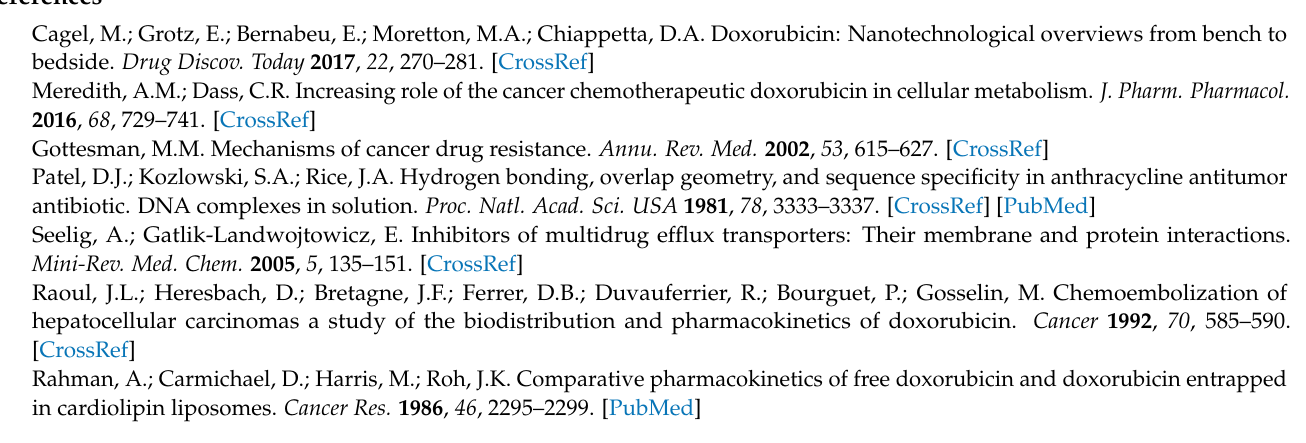
[(WR) 8 WK β A]-Dox conjugate; and Figure S7: Analytical HPLC purity profile of [(WR) 8 WK β A] -Dox